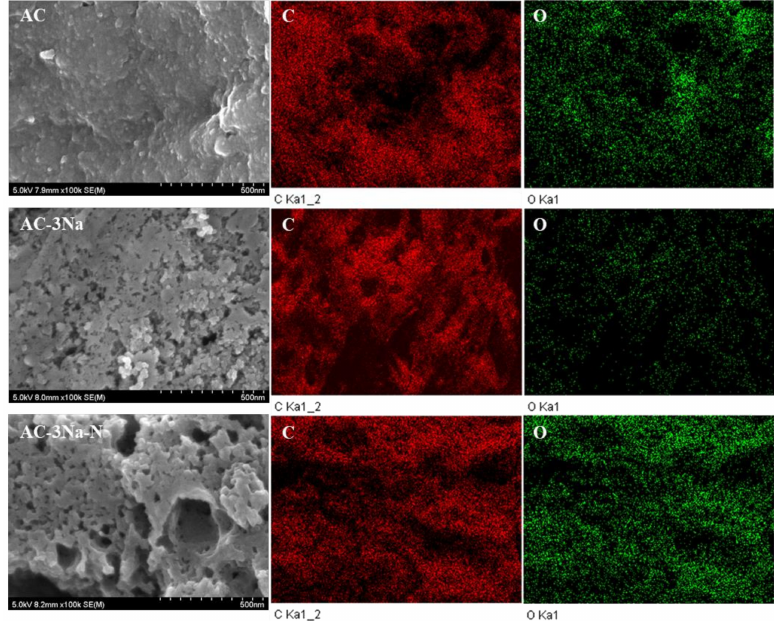
Figure 1. SEM surface texture and EDX elemental maps of AC, AC-3Na, and AC-3Na-N